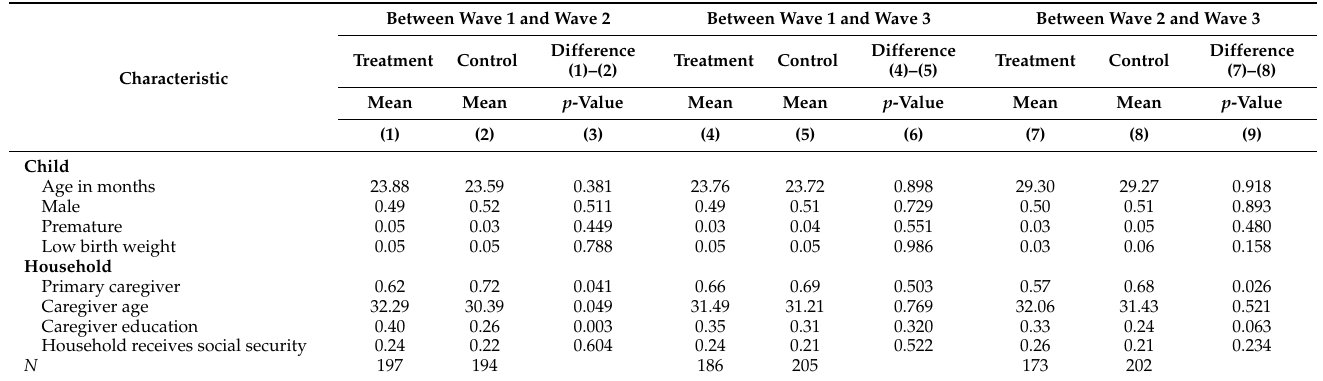
Table 2. Comparison of mean characteristics of treatments and comparisons (treatments: weakened parental beliefs; comparisons: stable high parental